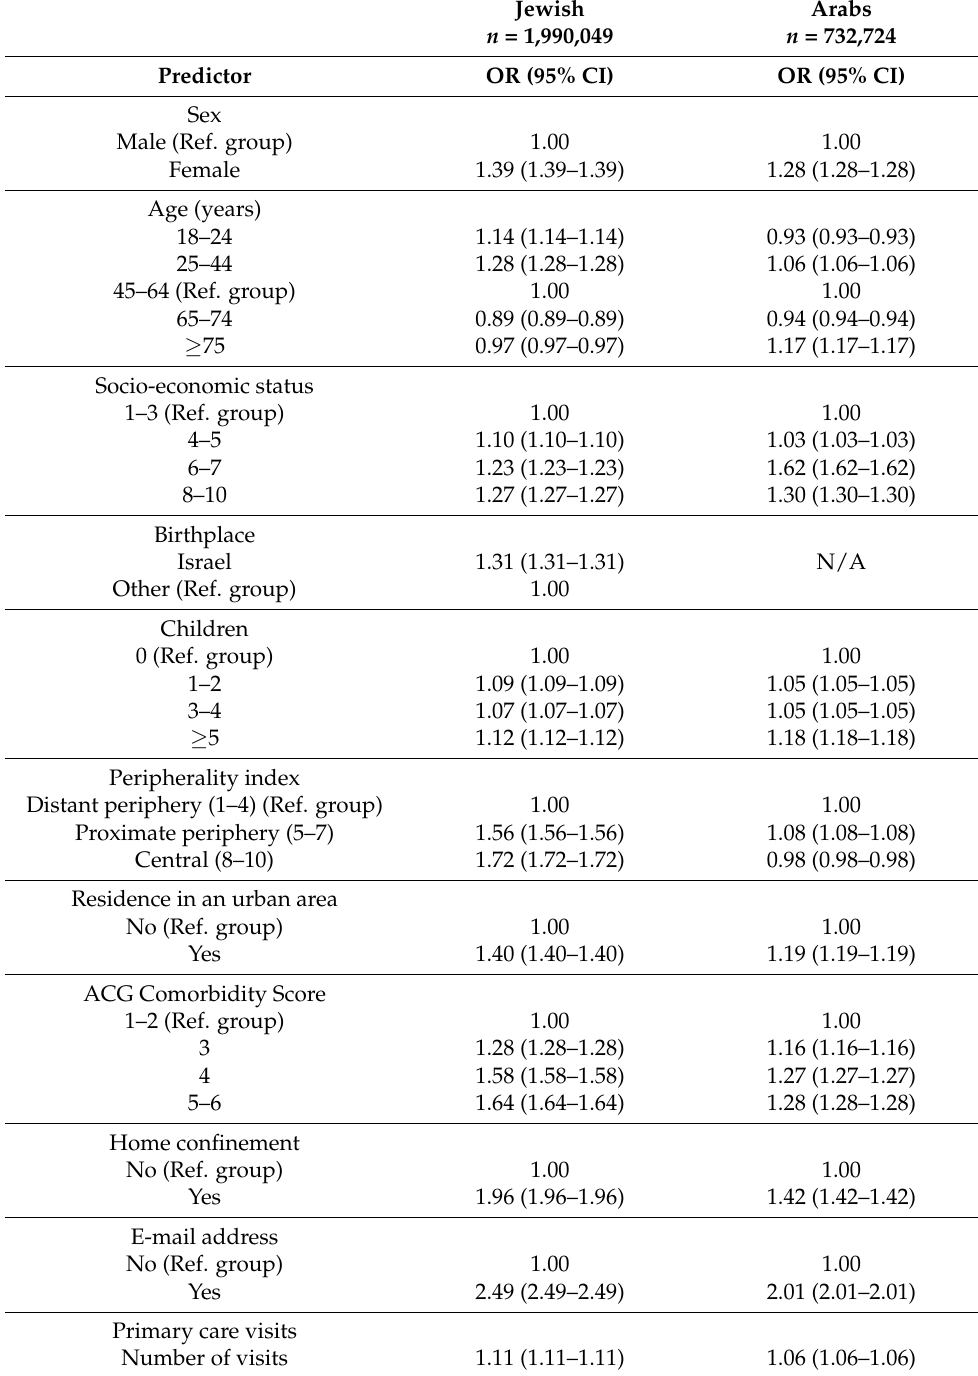
Table 2. Multivariable logistic regression for the association of personal factors with telemedicine use in primary healthcare during the COVID-19 pandemic stratified by ethnic